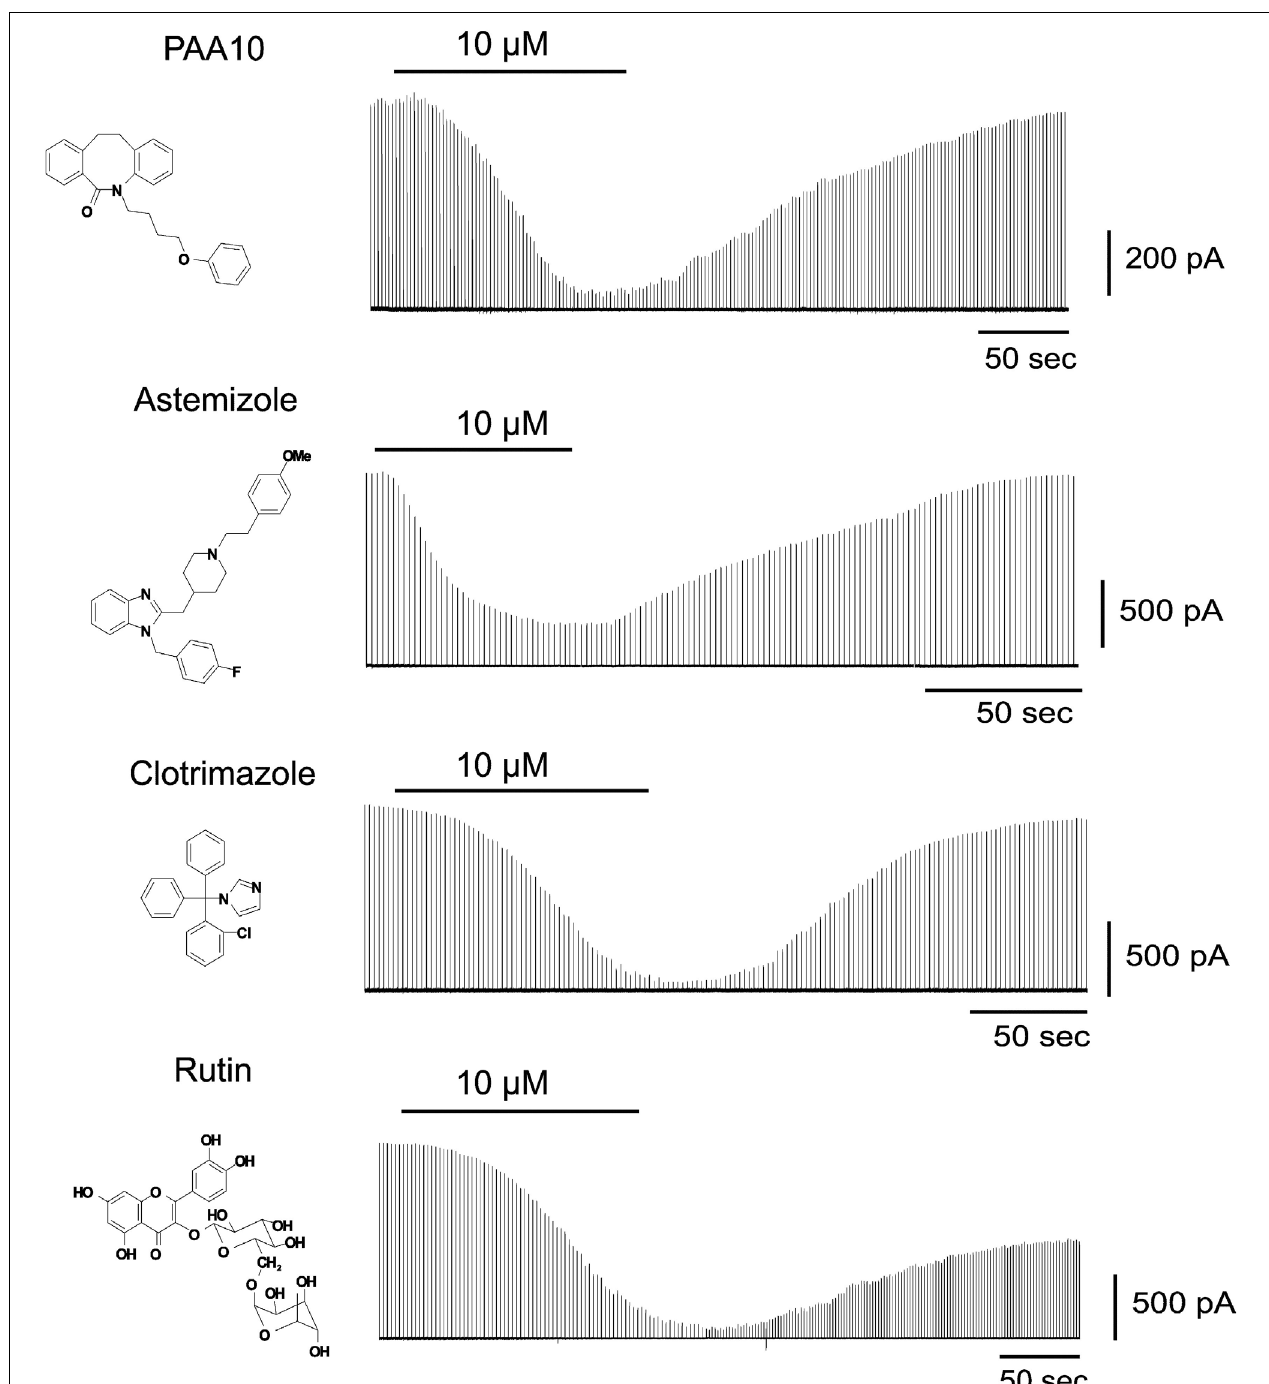
FIGURE 1 |Time course of the effect of PAA-10, astemizole, clotrimazole, and rutin on the junctional currents of Cx50 channels expressed in N2A cell pairs measured by dual whole-cell patch-clamp.